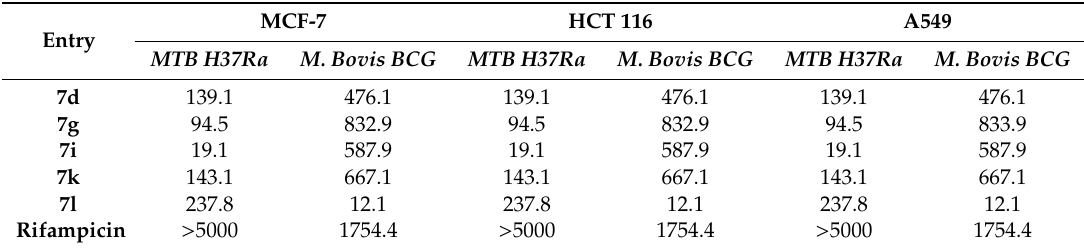
Table 3. Selectivity index against dormant M. bovis BCG and MTB H37Ra .